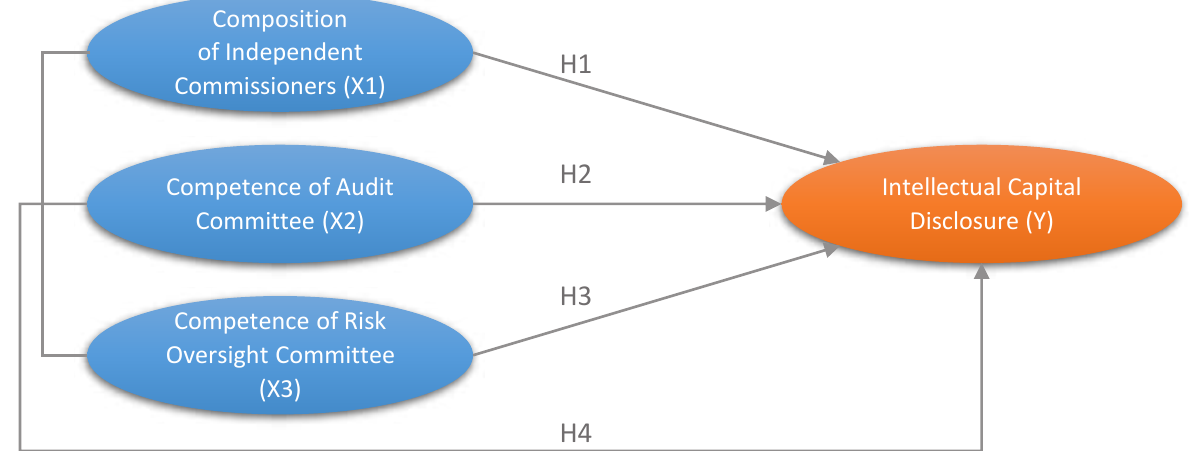
Figure 1. Conceptual